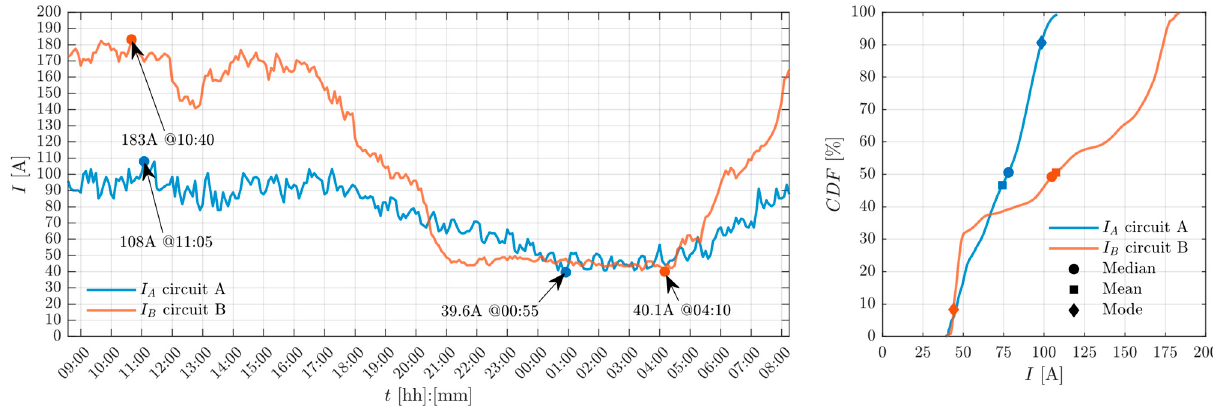
Figure 5. Instantaneous values of the currents over the 24 h ( left ) and its cumulative distribution function ( right ) in circuit A (blue trace) and circuit B (orange trace) starting from the 23rd of January.